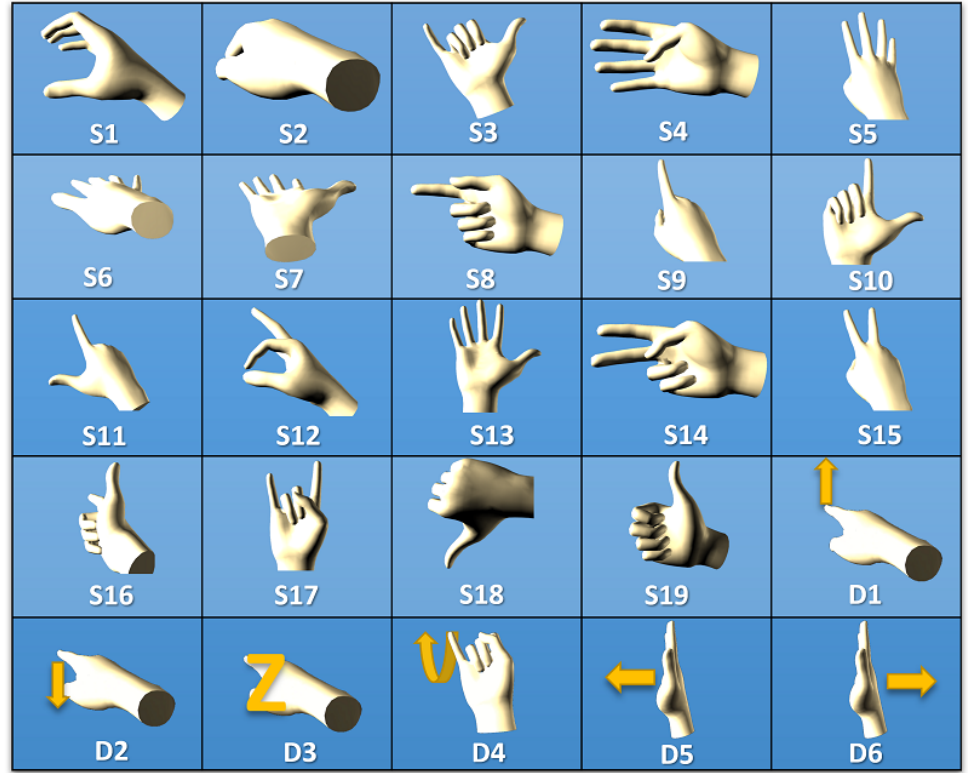
Figure 6. The 25 gestures that were used in the evaluation. S1–S19 are static gestures, and D1–D6 are dynamic